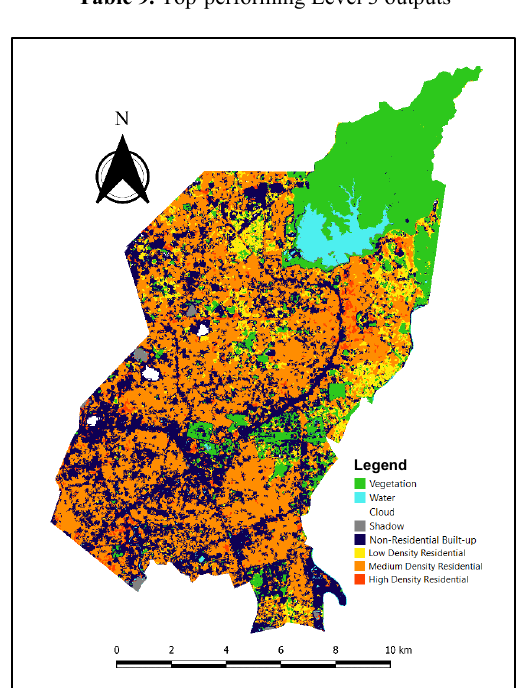
Figure 15. Best-performing Level 3 output (78.14% OA) showing land use land cover in Quezon City, including residential areas of various